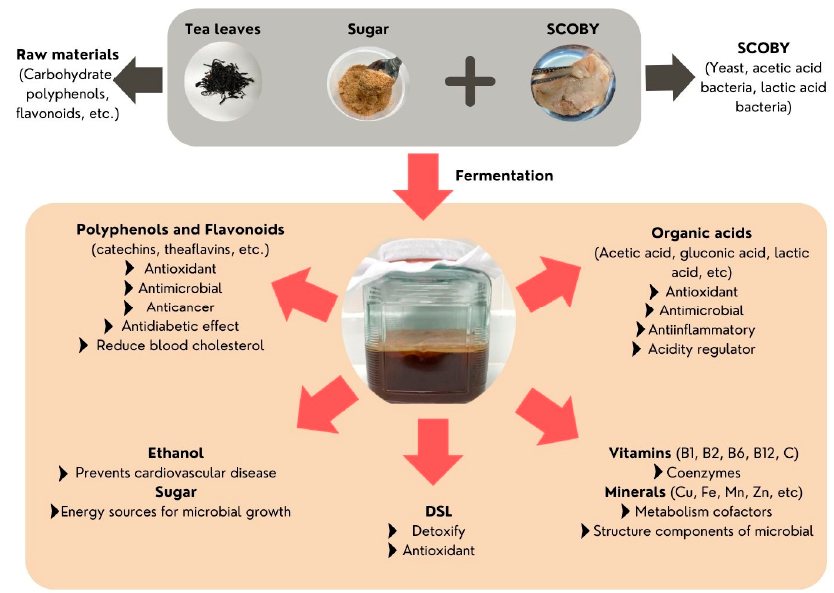
Figure 3. Kombucha beneficial compounds (modified from Leal et al. [9].